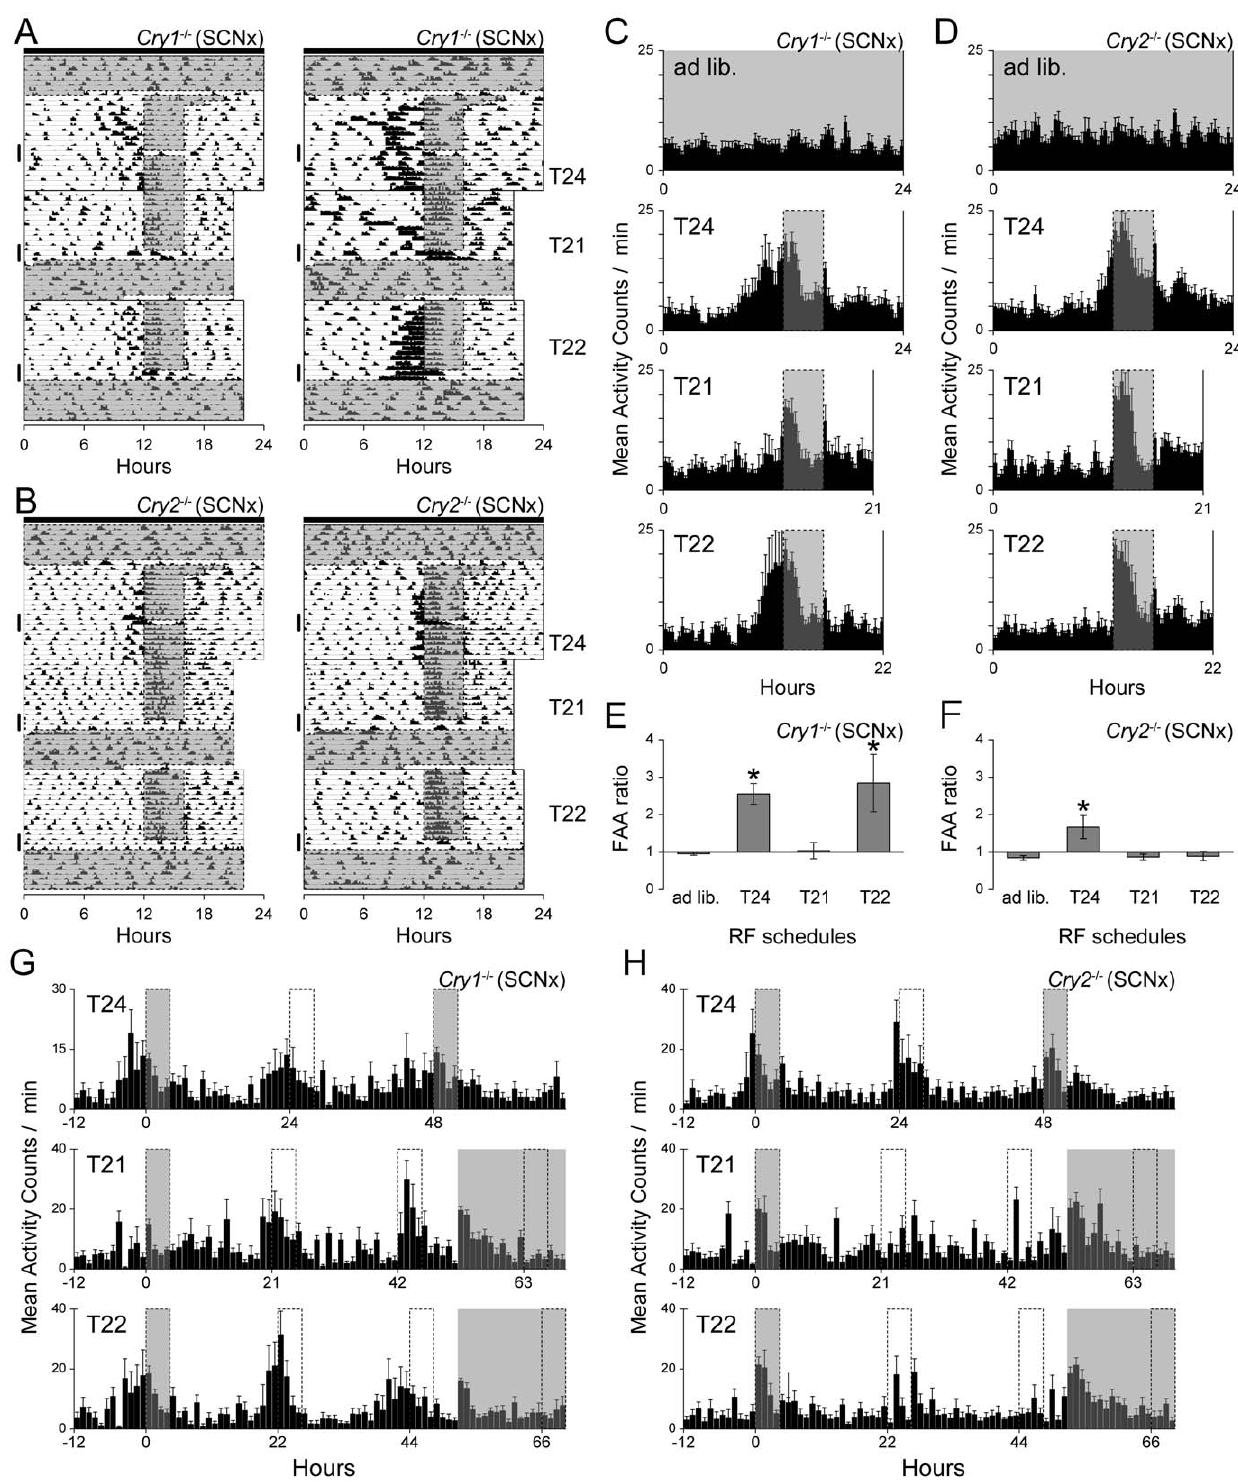
Figure 2. Limits of entrainment of FAA in Cry1- or Cry2 -deficient mice. Representative actograms of locomotor activity plotted at a day length corresponding to each feeding schedule in Cry1 2 / 2 ( A ) and Cry2 2 / 2 ( B ) mice with SCN ablation. Time is plotted left-to-right in 10-min bins. Mice were maintained in constant darkness as indicated by closed bars at the top of the actograms. Feeding time is indicated by gray shaded boxes. ( C and D ) Mean profiles of locomotor activities are plotted along each RF schedule ( C : Cry1 2 / 2 , n=8; D : Cry2 2 / 2 , n=7). Mean profile was calculated using individual mean 7-day profiles. Each data point represents counts per minute averaged across a 20-min bin. ( E and F) FAA ratios of Cry1 2 / 2 ( E ) and Cry2 2 / 2 ( F ) mice on serial feeding schedules. Significant differences are indicated by asterisks ( E : Cry1 2 / 2 , n=8; F : Cry2 2 / 2 , n=7, vs. ad libitum , ANOVA post-hoc Dunnett test). * P , 0.05 . ( G and H ) Mean serial plots of locomotor activity for 82 h represented in a 60-min bin. The last feeding time is set to zero. Cry -deficient mice were food-deprived for 44 h during the 24-h RF schedule ( G_T24 and H_T24 ), then returned to a 24-h RF schedule